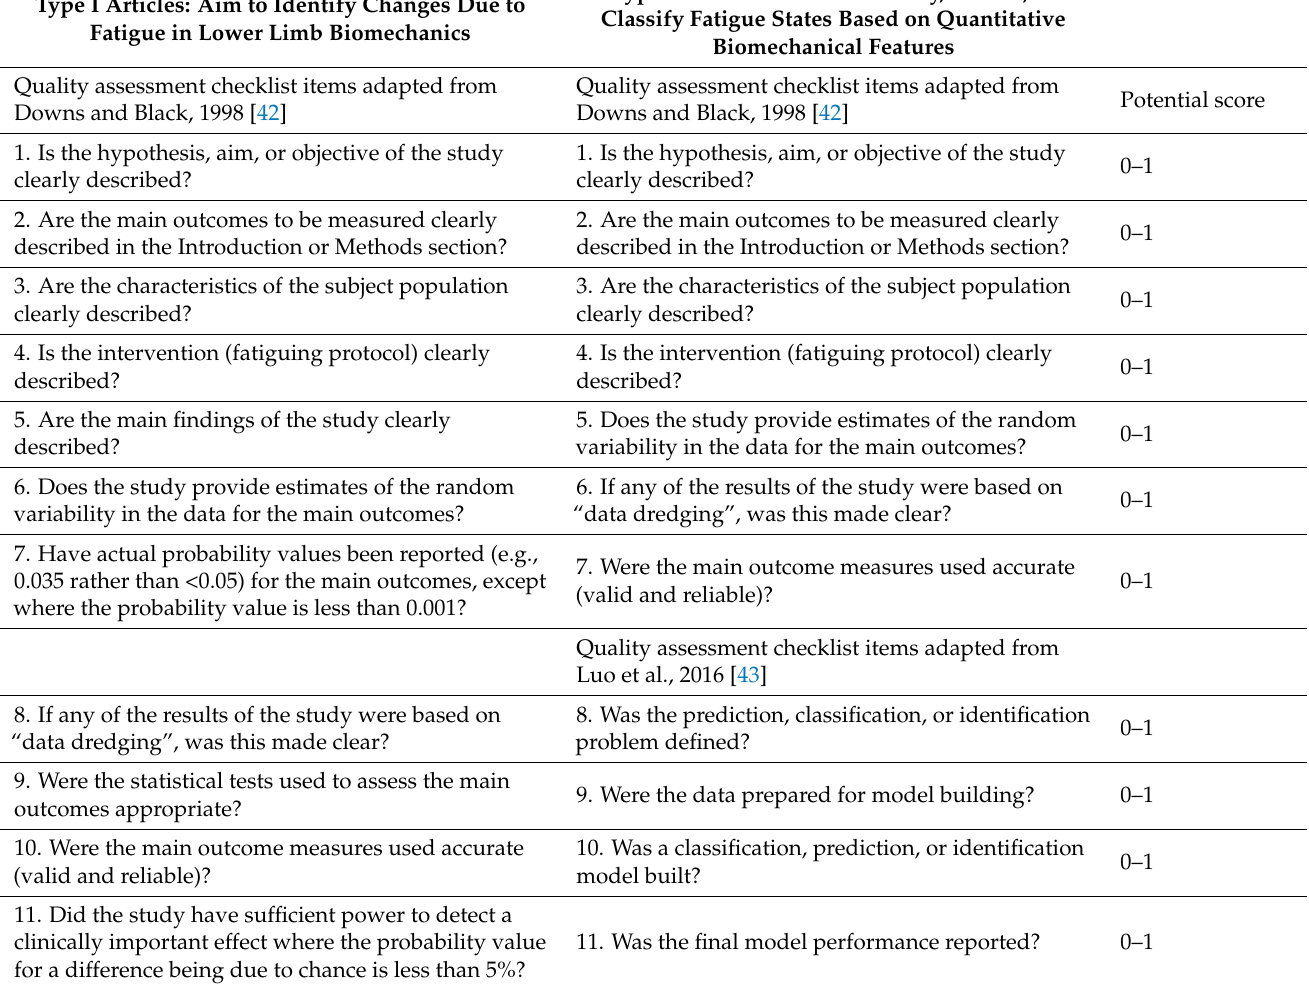
Table 1. Quality assessment